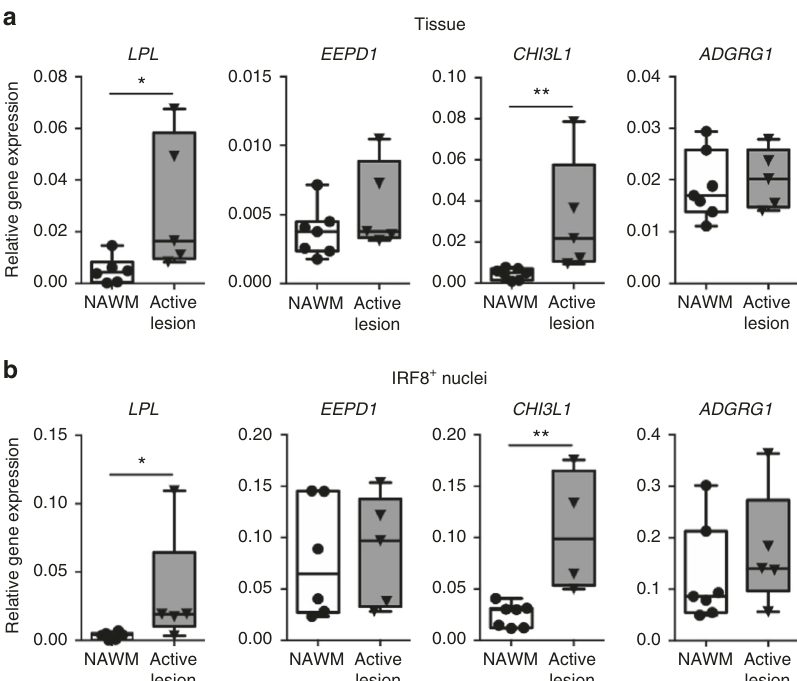
Fig. 5 Gene expression differences observed in normal-appearing white matter (NAWM) microglia relate to changes found in multiple sclerosis (MS) lesions. a Excised mixed active/inactive MS lesion tissue ( n = 5) shows increased expression of the differentially expressed genes LPL and CHI3L1 compared to NAWM ( n = 7) determined by quantitative reverse transcription polymerase chain reaction (RT-qPCR). EEPD1 and ADGRG1 expression is unaltered. Mann – Whitney U test: * p < 0.05, ** p < 0.01. b IRF8 + nuclei isolated from the same mixed active/inactive MS lesions demonstrates increased expression of CHI3L1 and LPL , compared to IRF8 + nuclei from NAWM, determined by RT-qPCR. In line with the tissue data, the expression of EEPD1 and ADGRG1 is not changed in IRF8 + nuclei from MS lesions. Mann – Whitney U one-tailed test: * p < 0.05, ** p < 0.01. Box plot center line shows median; whiskers show minimum – maximum